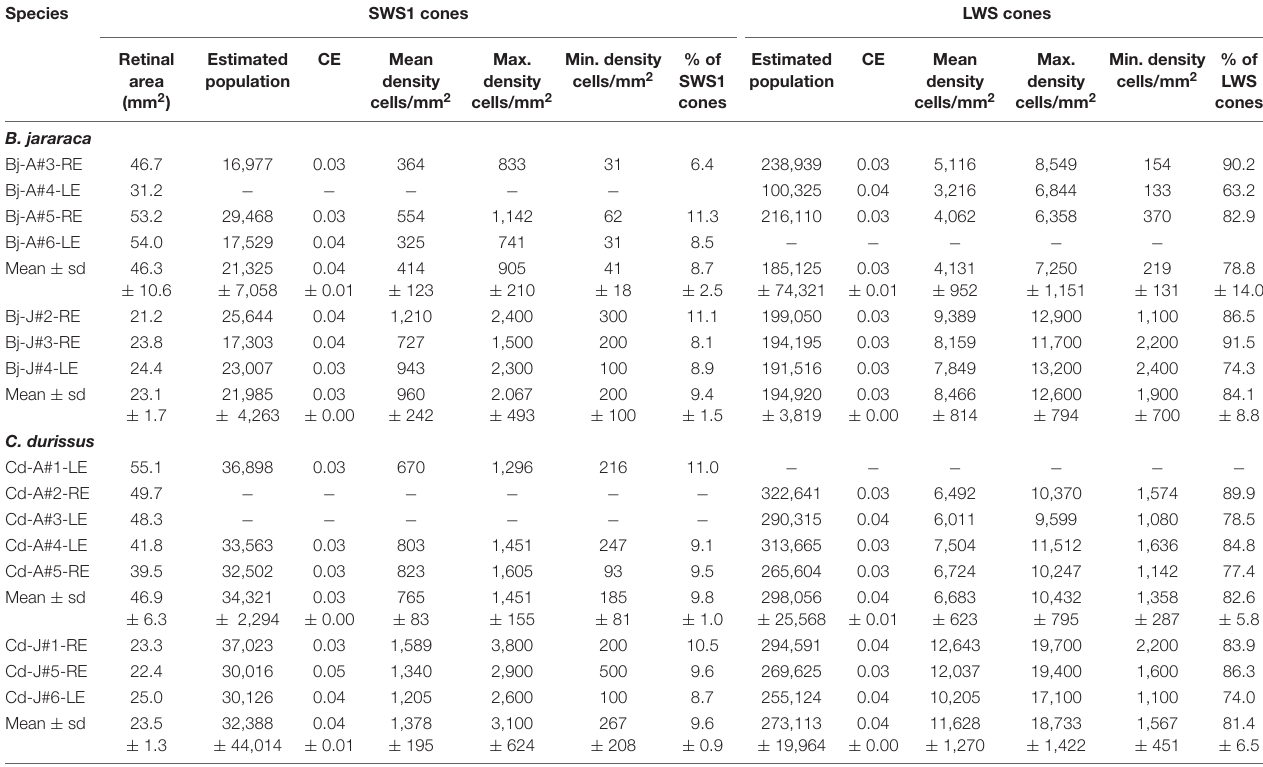
TABLE 3 | Stereological assessment of SWS1 and LWS cones in retinas of adults and juveniles of B. jararaca and C. durissus . Species SWS1 cones LWS